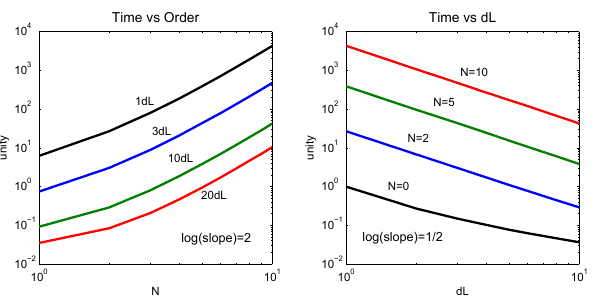
Figure 17: Log-log plot of computational time with a larger dL could be equivalent in CPU time as the standard MoM with 1 dL